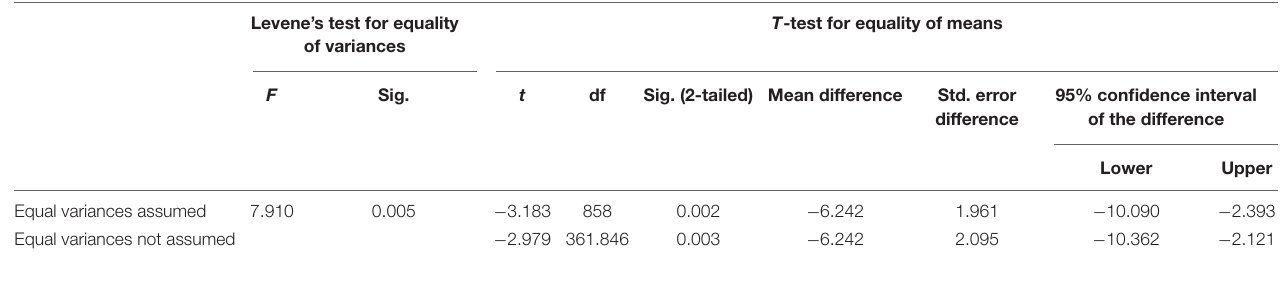
T -test for equality of